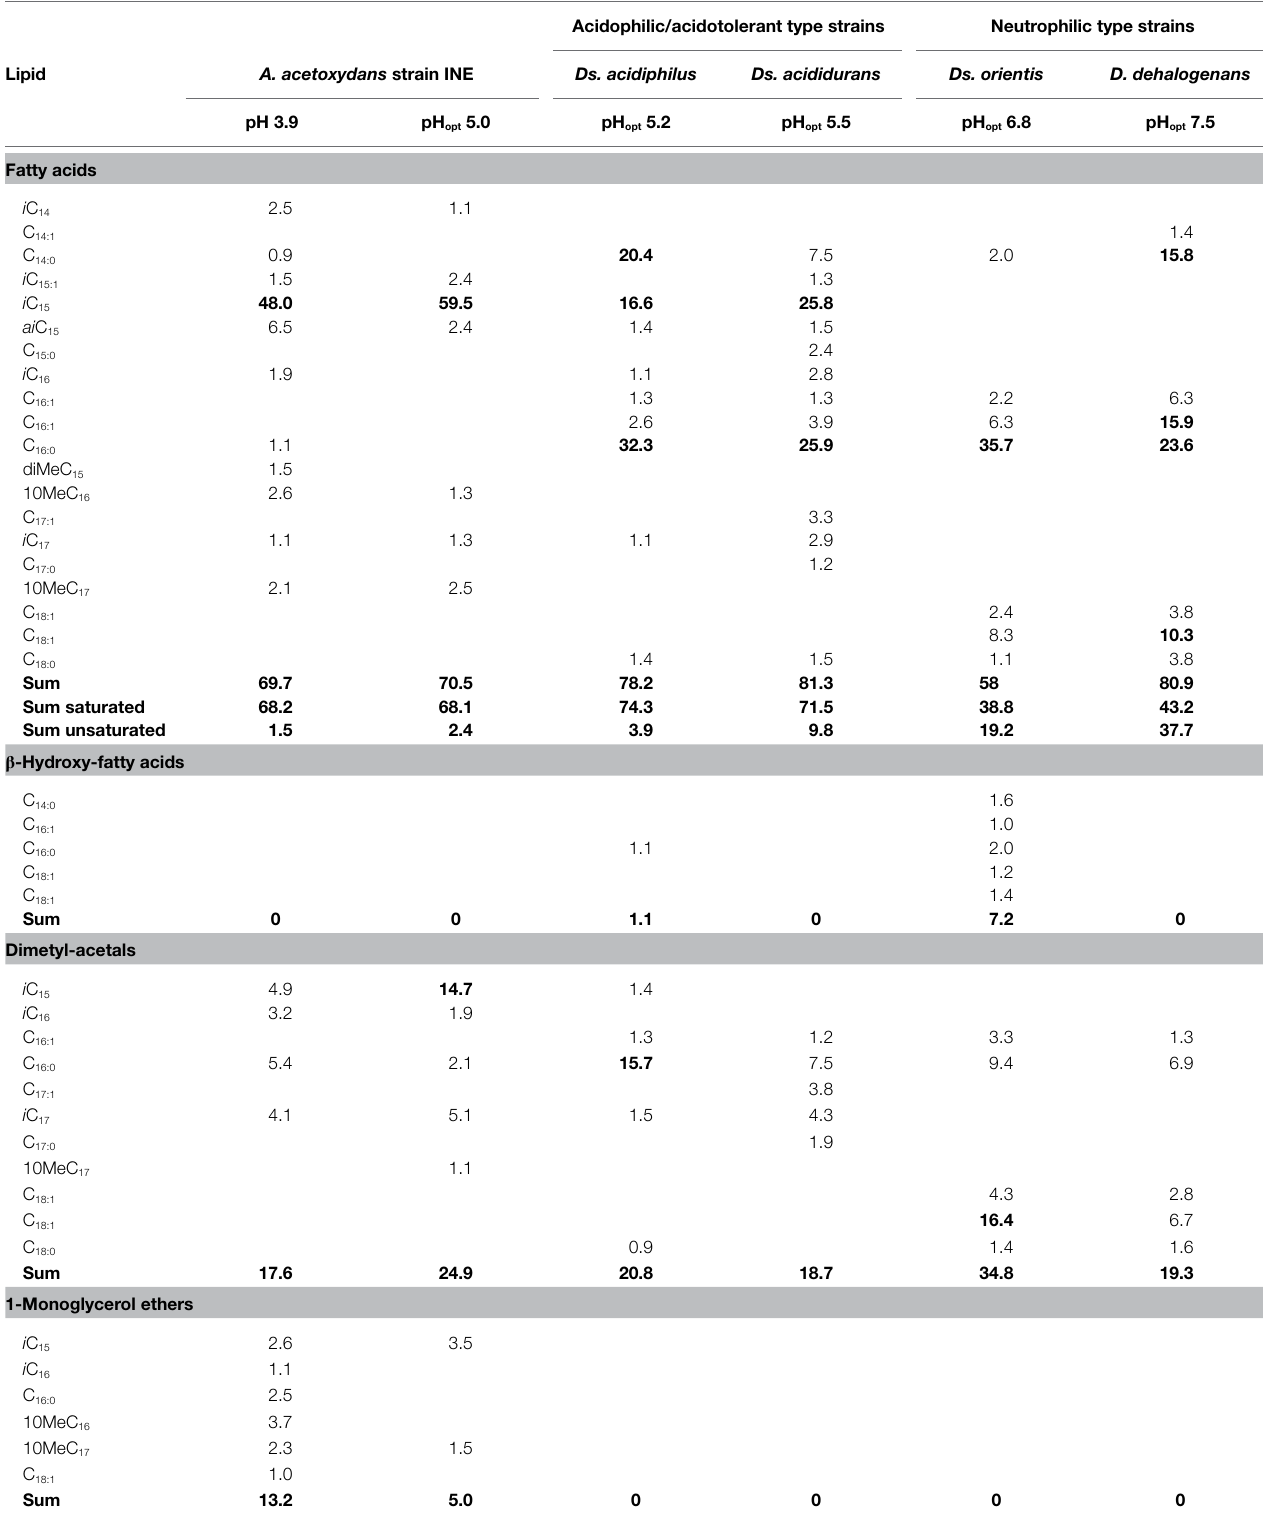
TABLE 2 | Relative abundance (% of total) of fatty acids and ether lipids of Acididesulfobacillus acetoxydans strain INE and its phylogenetically closest relatives grown on glycerol and sulfate.